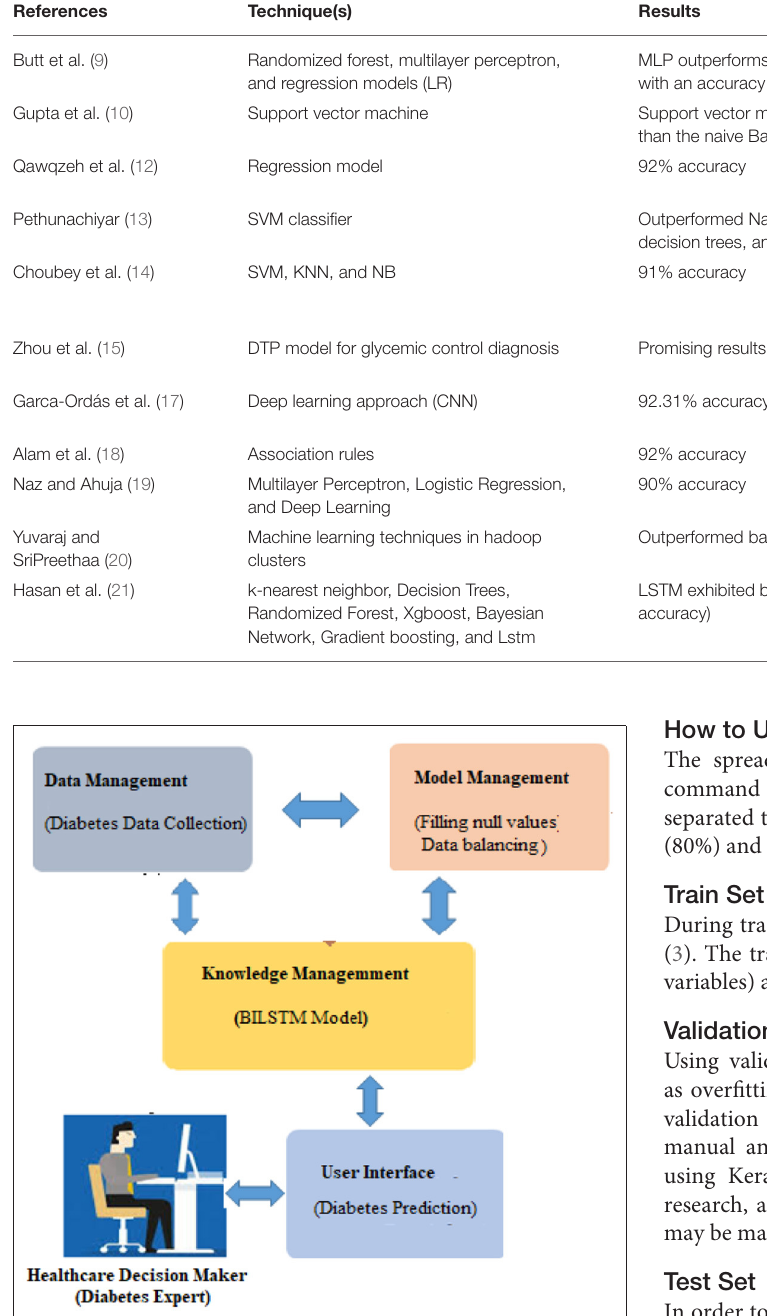
FIGURE 1 | Overview of the proposed system for predicting diabetes disease.